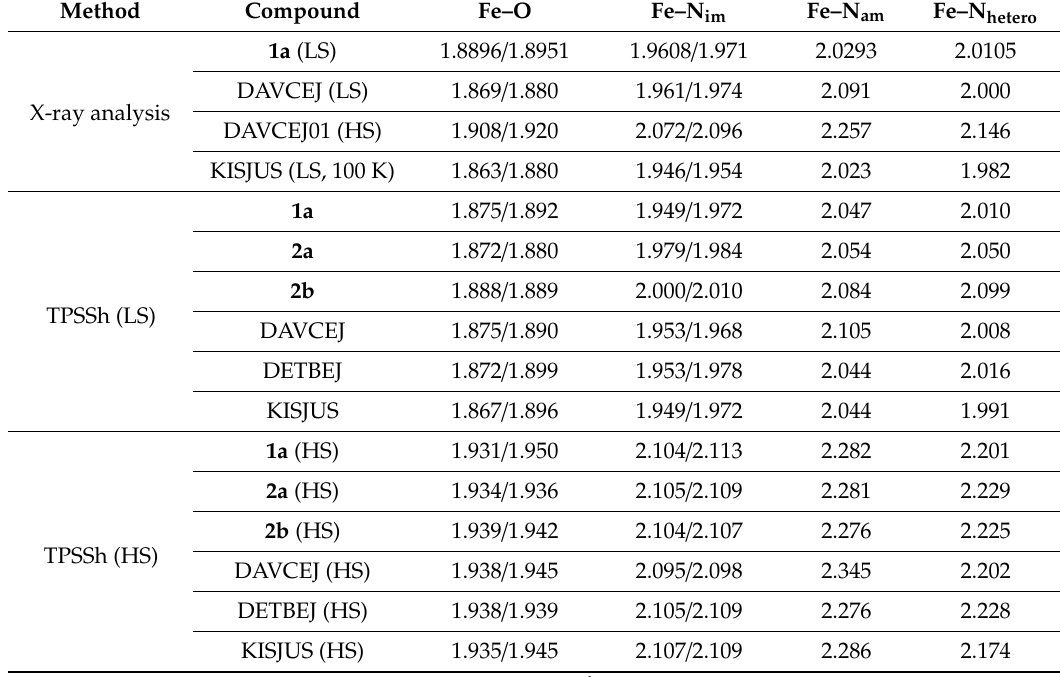
Table 3. The interatomic donor–acceptor distances for density functional theory (DFT)-optimized geometries of [Fe(R-LA)(L1)] + of 1a, 2a, and 2b and DAVCEJ, DETBEJ, and KISJUS using the TPSSh functional a.